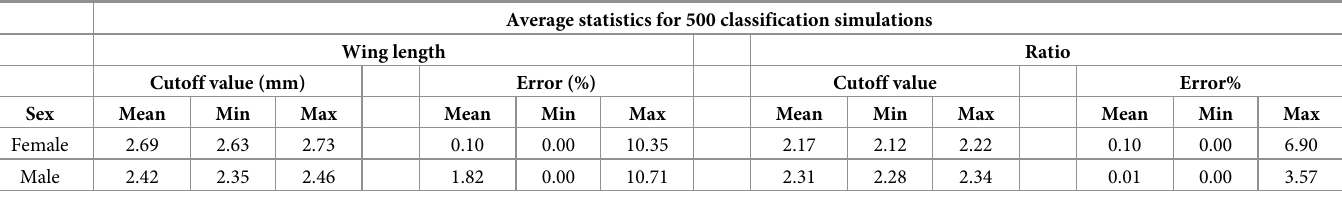
Table 2. Summary results using wing length or the transformed ratio of wing length to hind tibia to differentiate winter and summer morphs for females and